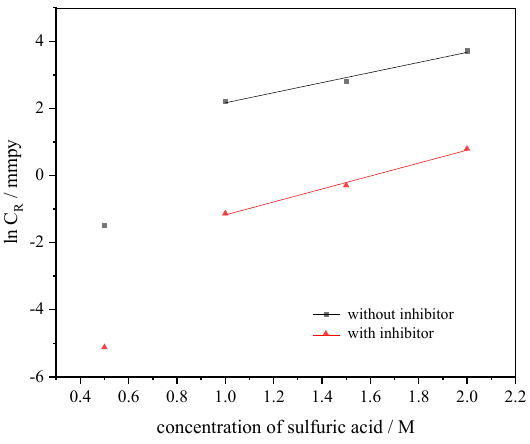
Figure 8. The straight lines of lnC R versus acid concentration with and without inhibitor at 25 °C. k can be deemed a commencing rate at zero acid concentration. Therefore, k means the corrosion ability of acid for metal. B represents the difference of the corrosion rate at the acid concentration. The decreased k with inhibitor (Table 4) means that the extracts inhibit the corrosion process of 304 SS [28]. The decreased B with inhibitor (Table 4) indicates that the changes of the corrosion rate in inhibited acid are larger than in uninhibited acid [28]. Table 4. Calculation of the linear regression between ln C R and C for the 304 SS corrosion in H 2 SO 4 solution.